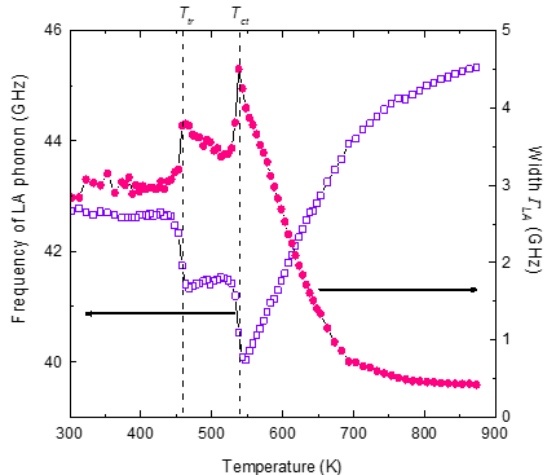
Figure 13. Temperature variation in the frequency and the width of the 0.65PIN-0.35PT LA pho- non.